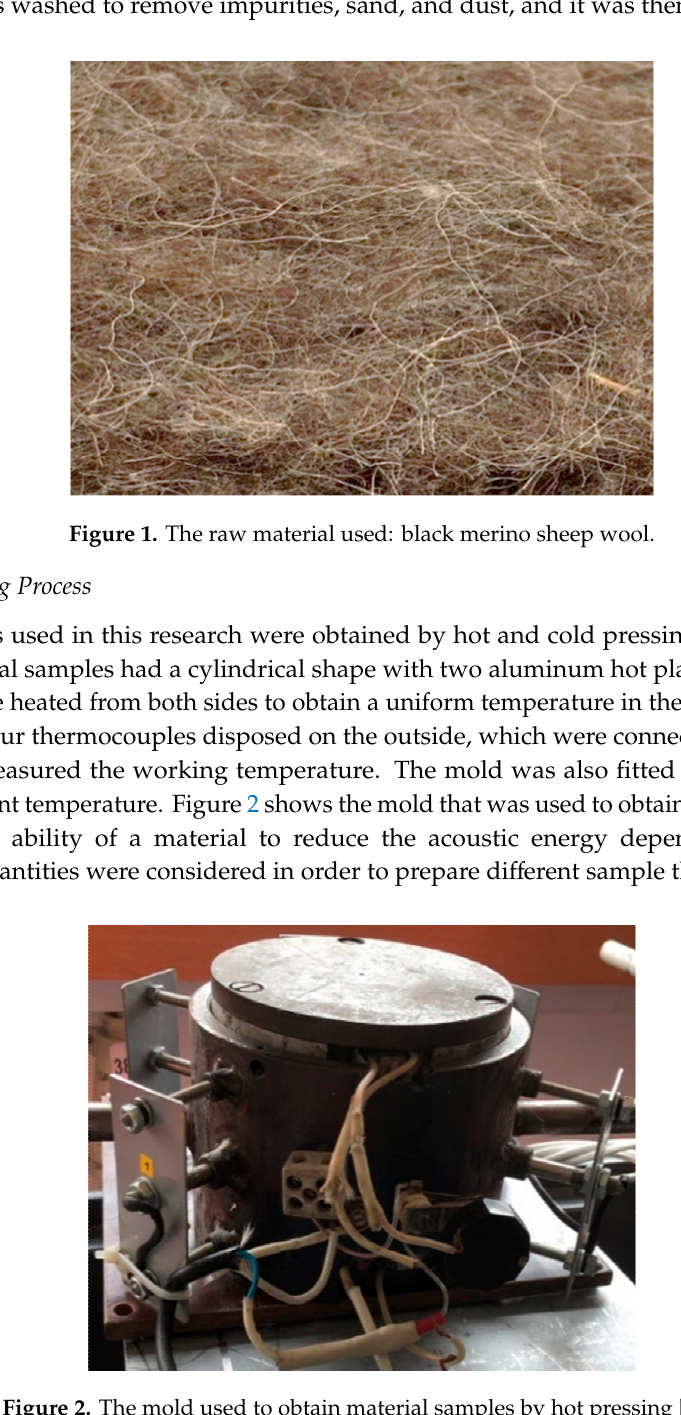
Figure 3. Groups of obtained materials. Table 1. Technical parameters of the materials obtained. Group